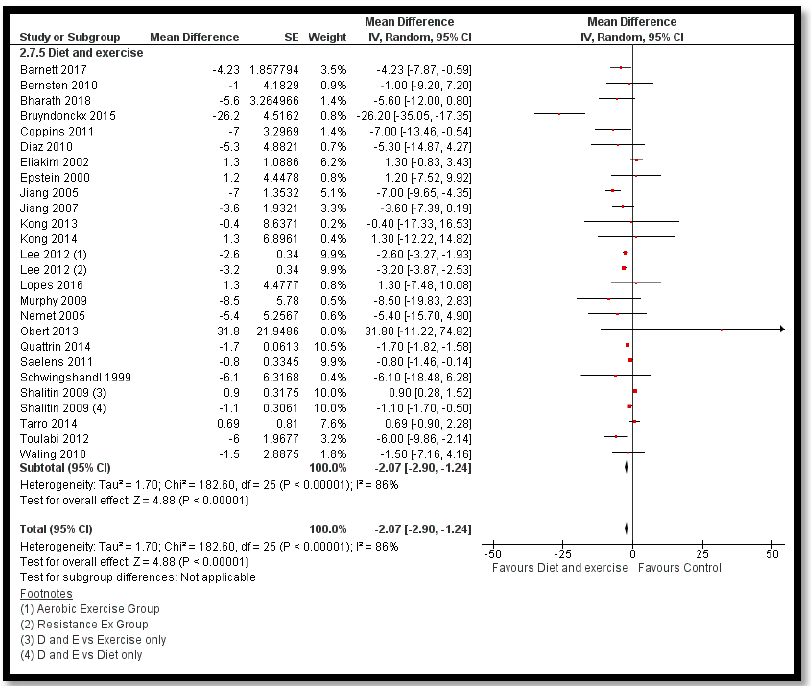
Figure 14. Forest plot for the effect of behavioural therpy only interventions for obesity management on body mass index (BMI).